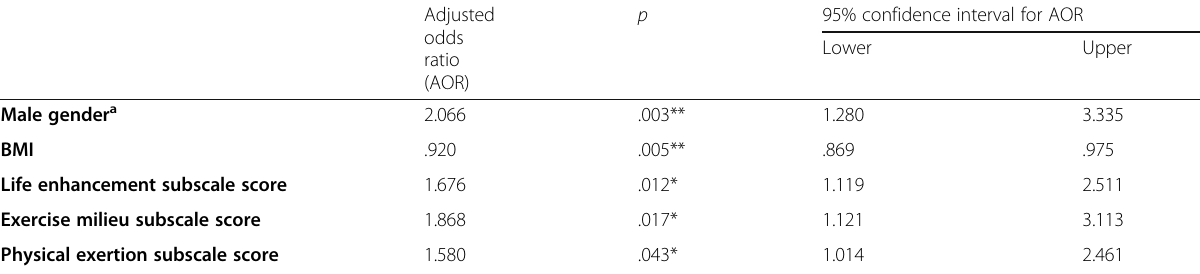
Table 5 Independent factors affecting exercise status by multivariate logistic analysis